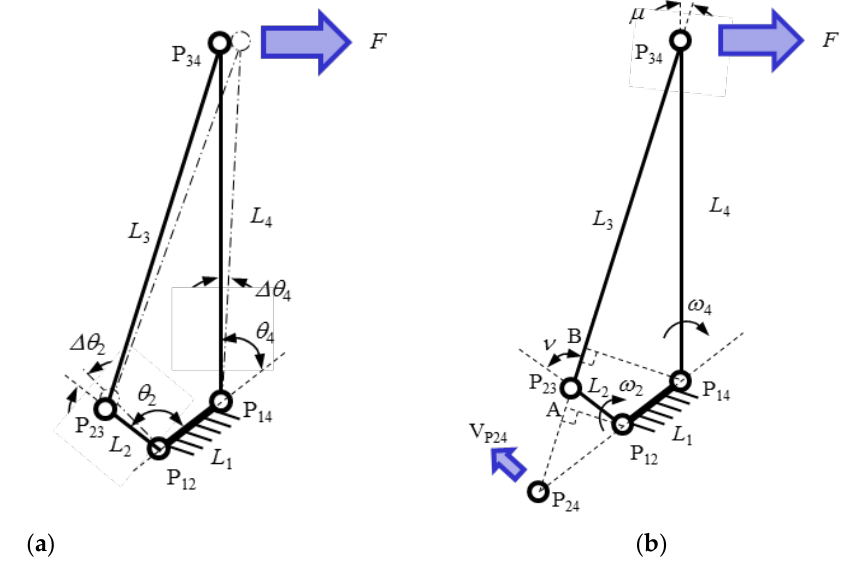
Figure 5. 4-bar linkage mechanism. ( a ) small rotation of 4-bar linkage, ( b ) instant center of 4-bar linkage